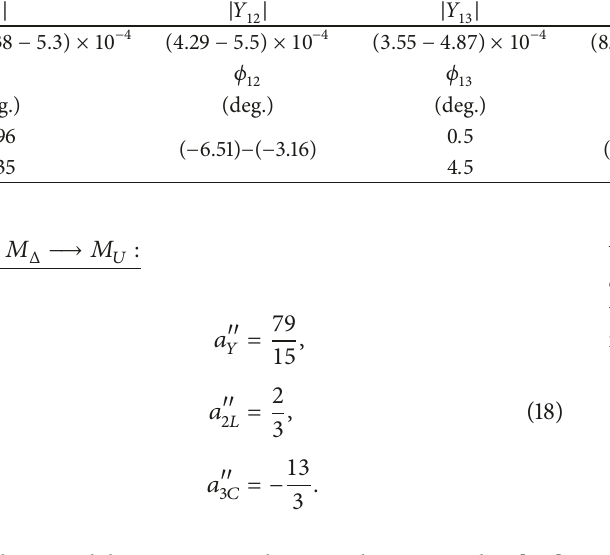
Table 2: Numerical values of the moduli ( |𝑌 푖푗 | ) and phases ( 𝜙 푖푗 ) ( 𝑖,𝑗 = 1, 2,3 ) of Yukawa coupling matrix for normally ordered (NO) light neutrino masses corresponding to 3𝜎 global fit of neutrino oscillation data. Lightest neutrino mass eigenvalue is kept fixed at 𝑚 1 = 0.00127 eV for the sake of simplicity. Randomly chosen Majorana phases 𝛼 푀 = 74.84 ∘ , 𝛽 푀 = 112.85 ∘ and the central value of the Dirac phase 𝛿 = 218 ∘ have been used. |𝑌 | |𝑌 | |𝑌 | |𝑌 | 11 12 13 22 (1.74 − 3.95) × 10 −5 𝜙 33 (deg.) (deg.) (deg.) (deg.) (deg.) (deg.) (−65.24) − (−61.73) (−48.50) − (−44.22) (−6.81) − (−5.34) 3.77 − 10.0 Table 3: Numerical values of the moduli ( |𝑌 푖푗 | ) and phases ( 𝜙 푖푗 ) ( 𝑖,𝑗 = 1, 2, 3 ) of Yukawa coupling matrix 𝑌 for invertedly ordered (IO) light neutrino masses corresponding to 3𝜎 global fit of neutrino oscillation data. Lightest neutrino mass eigenvalue is kept fixed at 𝑚 3 = 0.00127 eV. Phase angles used are the same as in Table 2. |𝑌 | 11